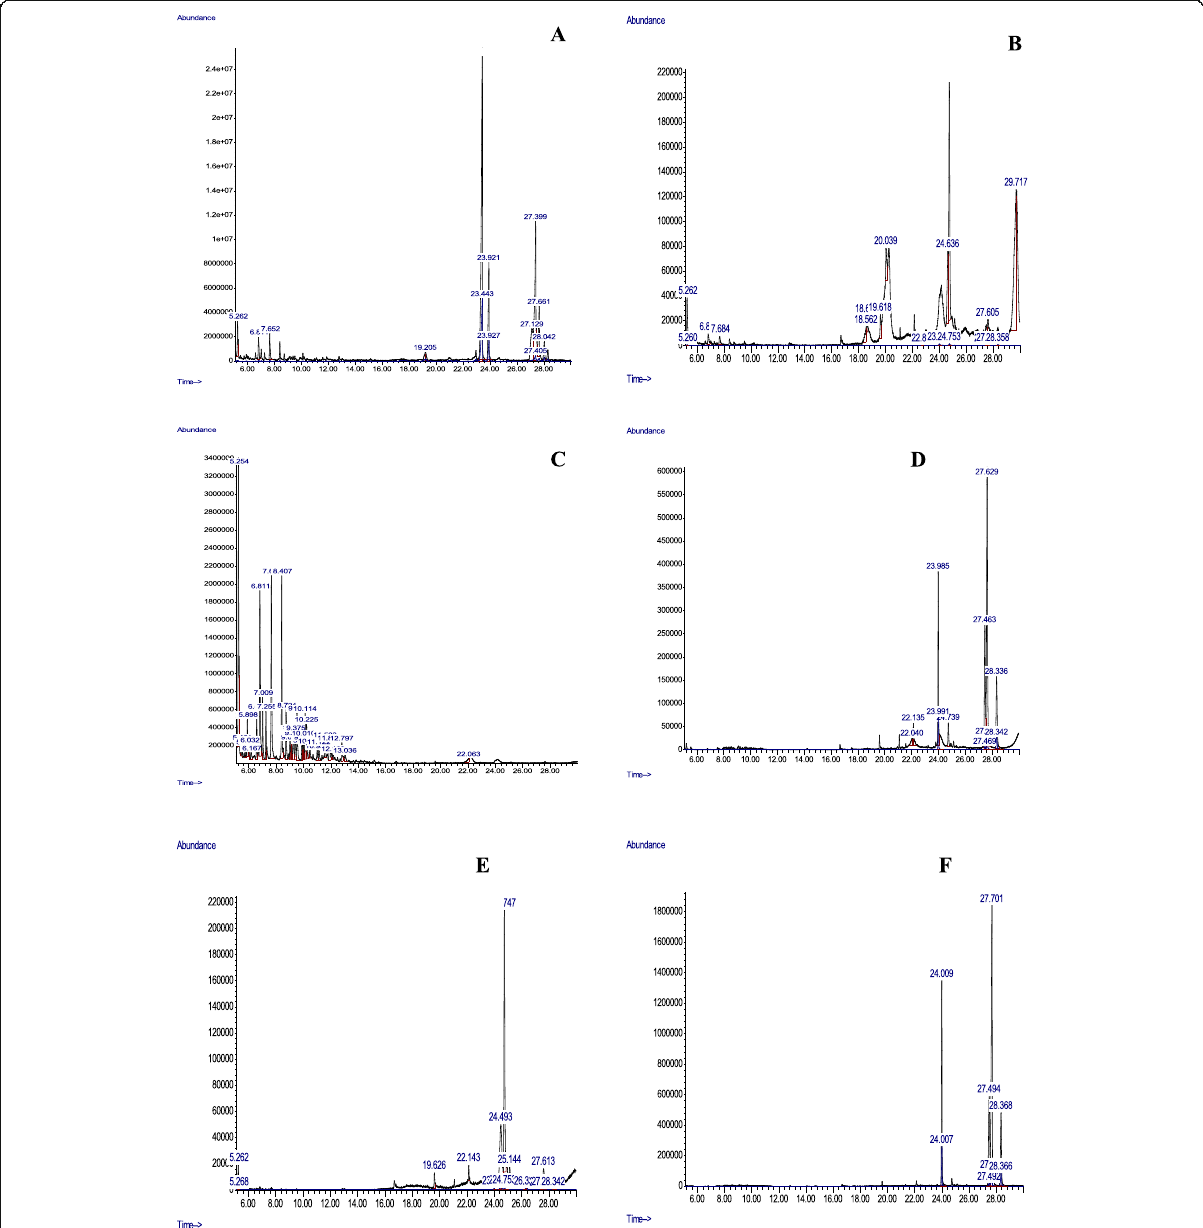
Fig. 4 GC-MS chromatograms. a Petroleum ether extract of A . occidentale . b Ethylacetate extract of A . occidentale . c n -Hexane extract of P . guajava . d Chloroform extract of P . guajava . e Ethylacetate extract of P . guajava . f Ethylacetate extract of T .